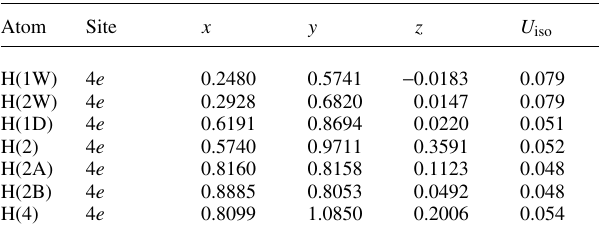
Table 2. Atomic coordinates and displacement parameters (in Å 2 )